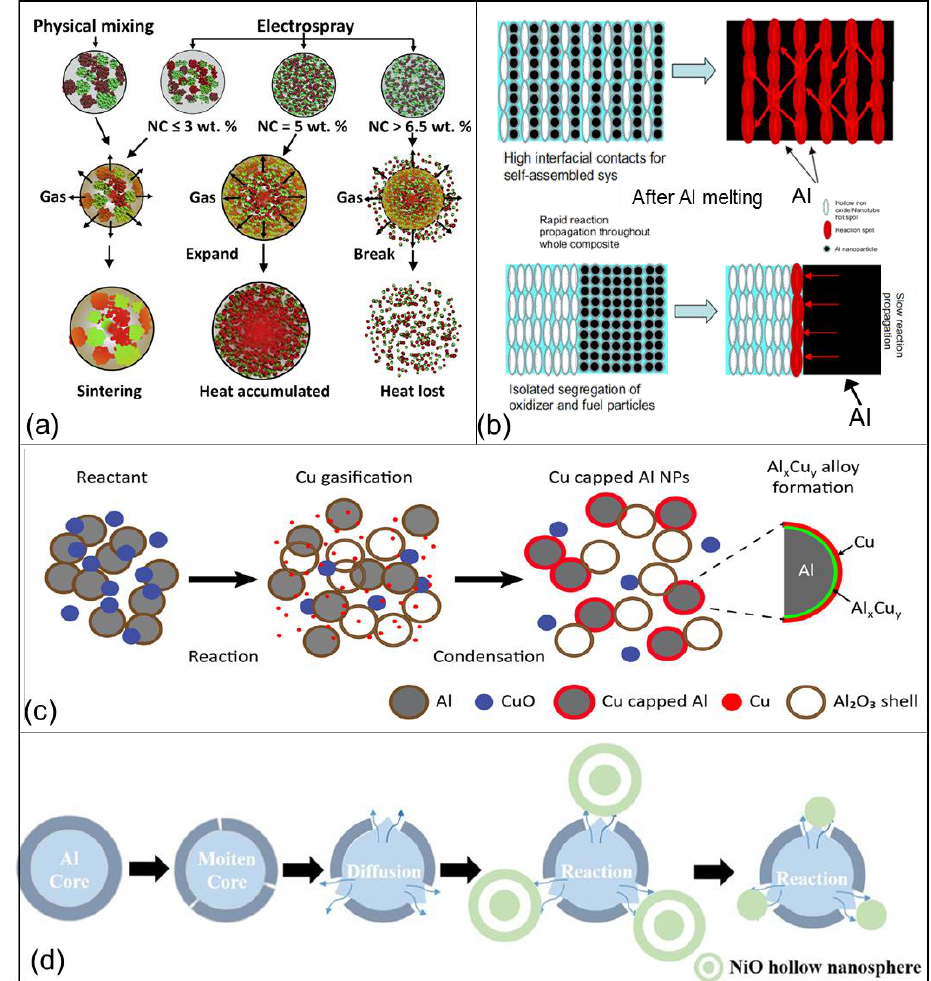
Figure 10. ( a ) Possible mechanisms of the burning of Al/CuO/NC nEMs made from physical mixing and electrospray. Note: Al (red); CuO (green); nitrocellulose (light blue) [142] Copyright 2014, Combustion and Flame, ( b ) the schematic illustration showing an exaggerated perspective that demonstrates random versus ordered assembly [48] Copyright 2010, Combustion and Flame, ( c ) schematic illustration of Al/CuO thermite reaction steps. Condensation of gasified Cu species on Al NPs hamper’s reaction of Al NPs with neighboring CuO NPs [88] Copyright 2015, Combustion and Flame, and ( d ) combustion process of Al/NiO nEMs [131] Copyright 2020, Chemical Engineering Journal.